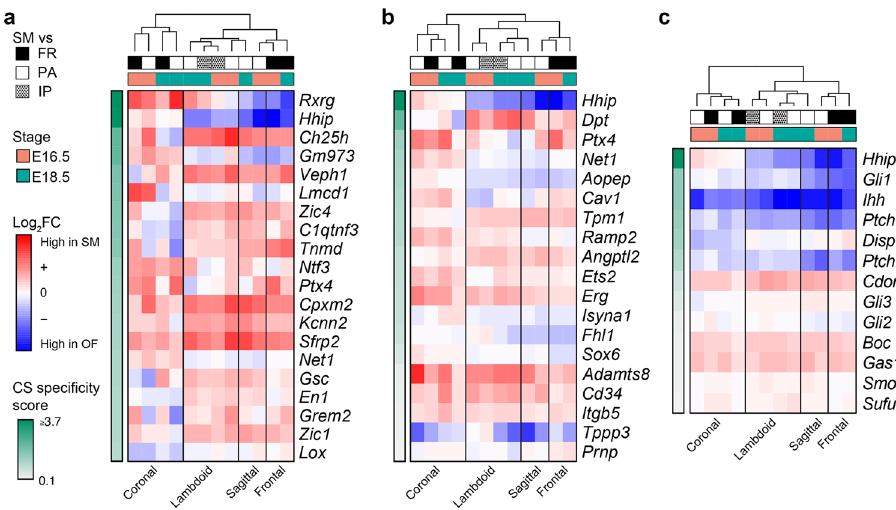
Fig. 3 Enrichment of Hhip expression in SM is speci fi c to the coronal suture. a Average bulk gene expression changes of the signi fi cant marker genes (rows) of all SM populations across the four calvarial sutures. Expression changes are shown as the log2FC between the SM and osteogenic fronts (OF) at E16.5 and E18.5, ranked by their ‘ coronal speci fi city score ’ (CS), representing the difference between the average expression across the coronal suture data and the average expression across the remaining sutures (lambdoid, sagittal, and frontal). Frontal OF (FR), parietal OF (PA), interparietal OF (IP). b Average bulk gene expression changes of the combined top ten marker genes of SM populations CS6-4 and CS8-2 across the four calvarial sutures. Expression changes are shown as in a . c Average bulk gene expression changes of key hedgehog pathway genes across the four calvarial sutures. Expression changes are shown as in a